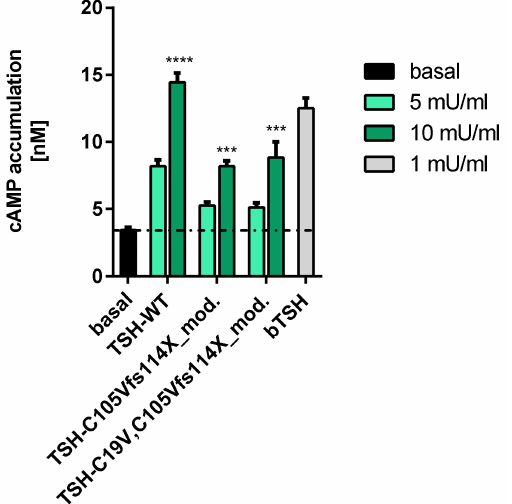
Figure A3. WT-TSH and modified mutant-TSH signaling at TSHR in FTC133-TSHR cells. Functional characterization of Gs / adenylyl cyclase signaling of WT-TSH and mutants at TSHR in FTC133 cells with di ff erent ligand concentrations. The basal activity of TSHR is shown as black bar / black line. bTSH (1 mU) functions as positive control. Data are expressed as mean ± SEM of four independent experiments performed in triplicate. For statistical analysis, one-way ANOVA with the Kruskal-Wallis test was used to test basal activity of the TSHR against the WT and TSH mutants. p *** < 0.001; **** p <